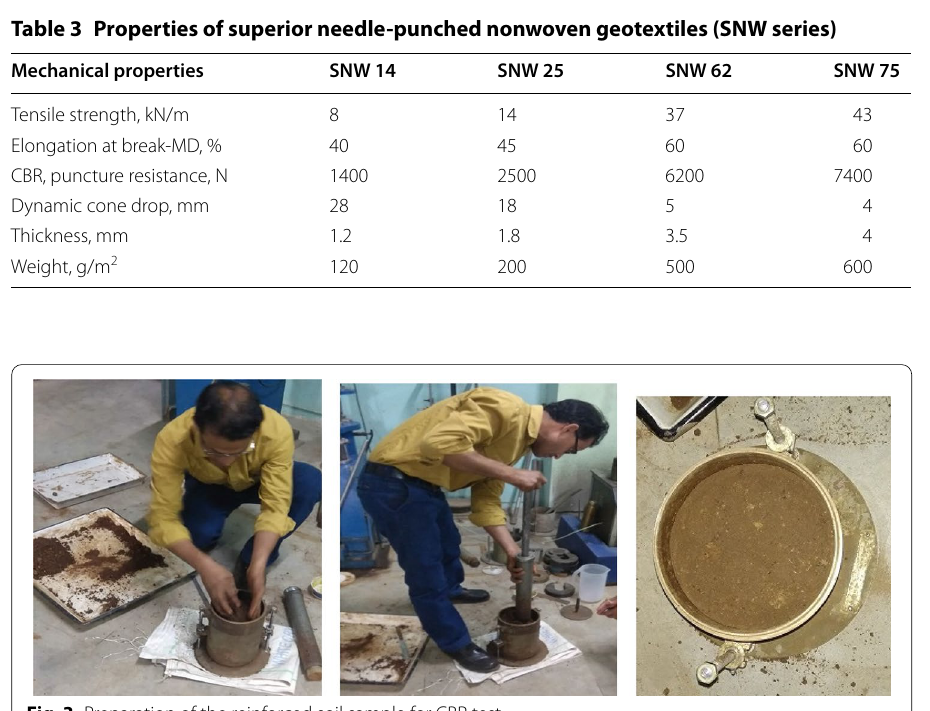
Fig. 3 Preparation of the reinforced soil sample for CBR